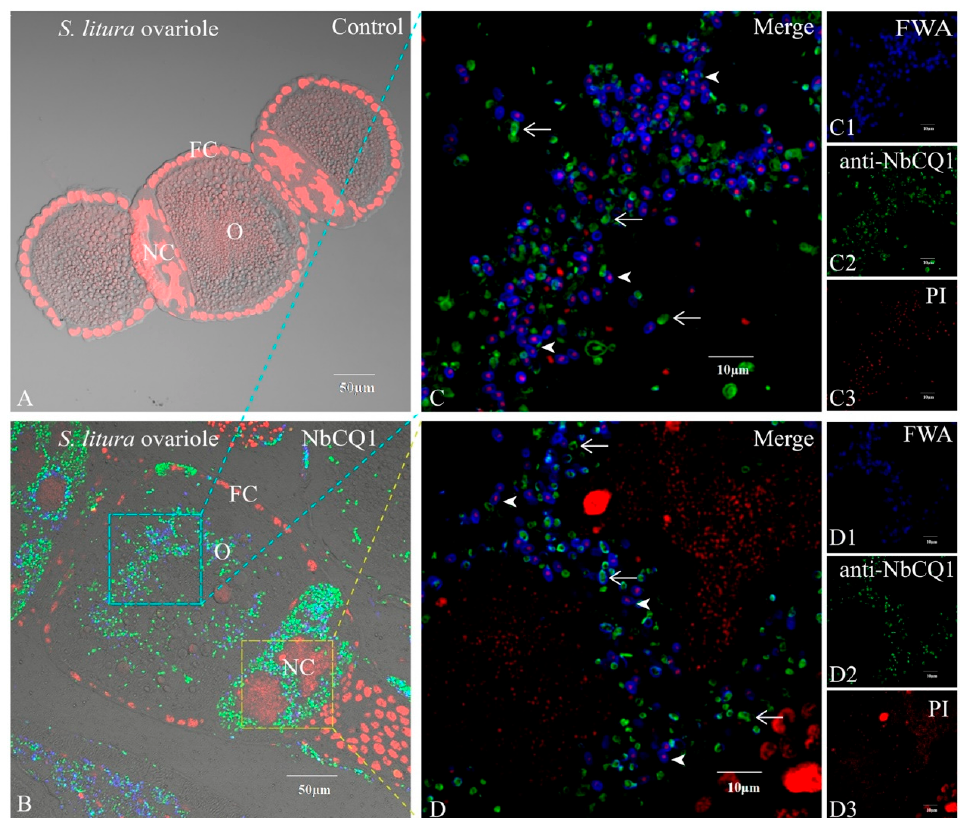
Figure 3. Paraffin sections of S. litura ovariole infected by NbCQ1. ( A ) Uninfected ovariole; ( B ) Infected ovariole; ( C ) An enlarged view of the infection of oocyte; ( D ) An enlarged view of the infection of follicle cell; ( C1 , D1 ) NbCQ1 spores stained with FWA; ( C2 , D2 ) Proliferative NbCQ1 labeled with antibody; ( C3 , D3 ) Nucleus stained by PI. FC: follicle cell; O: oocyte; NC: nurse cell; Arrowhead shows mature spore; Arrow shows parasite proliferation.